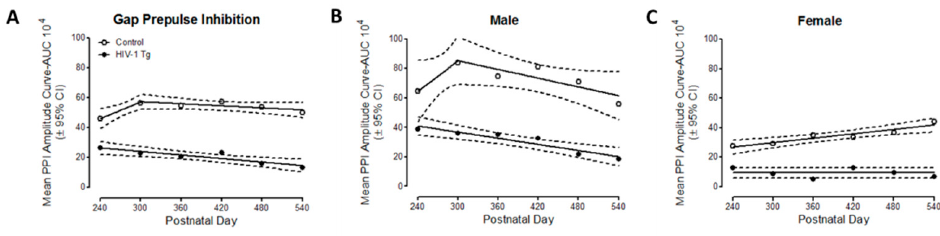
Figure 3. Neurocognitive assessments of temporal processing were evaluated using gap-prepulse inhibition (gap-PPI). The mean peak ASR amplitude response curve for gap-PPI was used to calculate prepulse inhibition in HIV-1 Tg and control rats from PD 240 to PD 540. ( A ) At the genotypic level, HIV-1 Tg animals exhibited a profound alteration in the progression of temporal processing relative to control animals. ( B , C ) Fundamentally, both male ( B ) and female ( C ) HIV-1 Tg animals